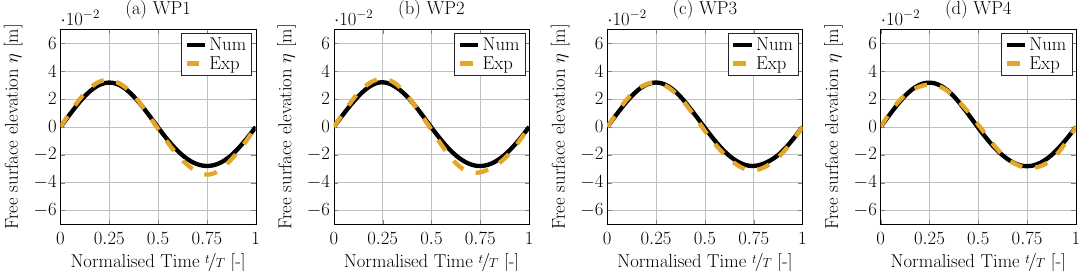
Figure 7. Phase-averaged free surface elevation, measured at wave probes WP1–WP4 ( a – d ), for wave RW2.